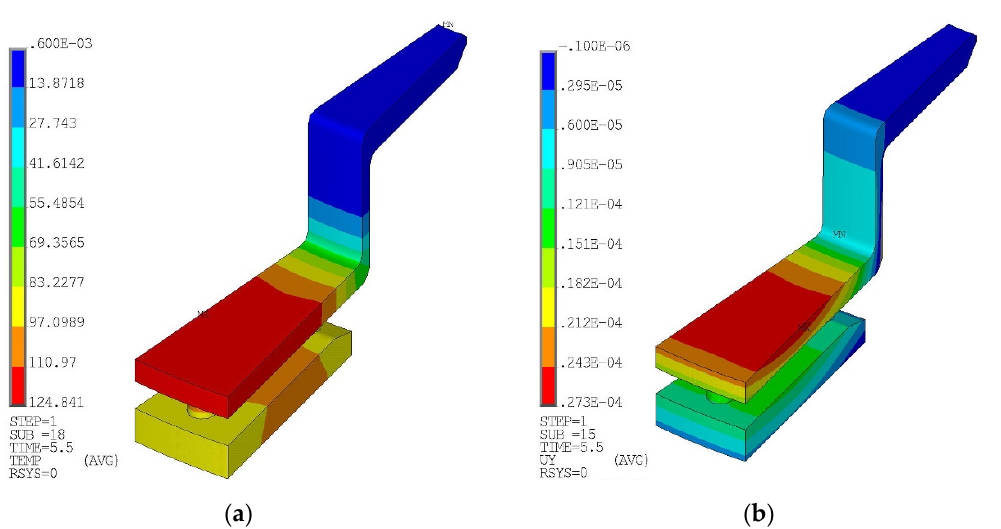
Figure 16. Optimization results for Case 2 at time = 5.5 s: ( a ) temperature distribution; ( b ) deformation in y-direction.